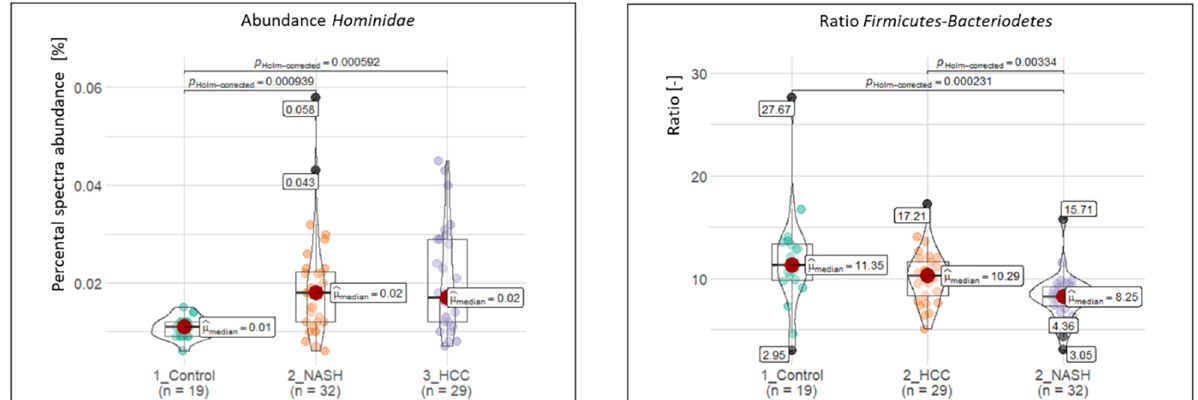
Figure 2. Abundance of the family Hominidae and the ratio of Bacteriodetes to Firmicutes. The abundance is based on the normalized abundance of identified spectra.